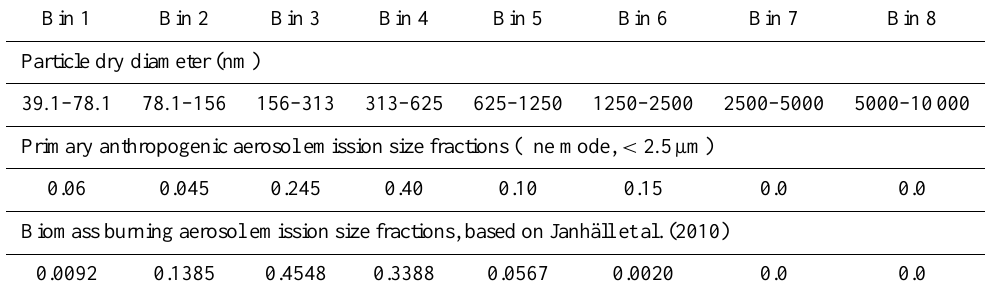
Table 1. Fractional apportionment of particulate emissions across the eight MOSAIC size bins, showing range of particle diameters for each bin, primary anthropogenic emission size fraction and biomass burning emission fractions, based on Janhäll et al.